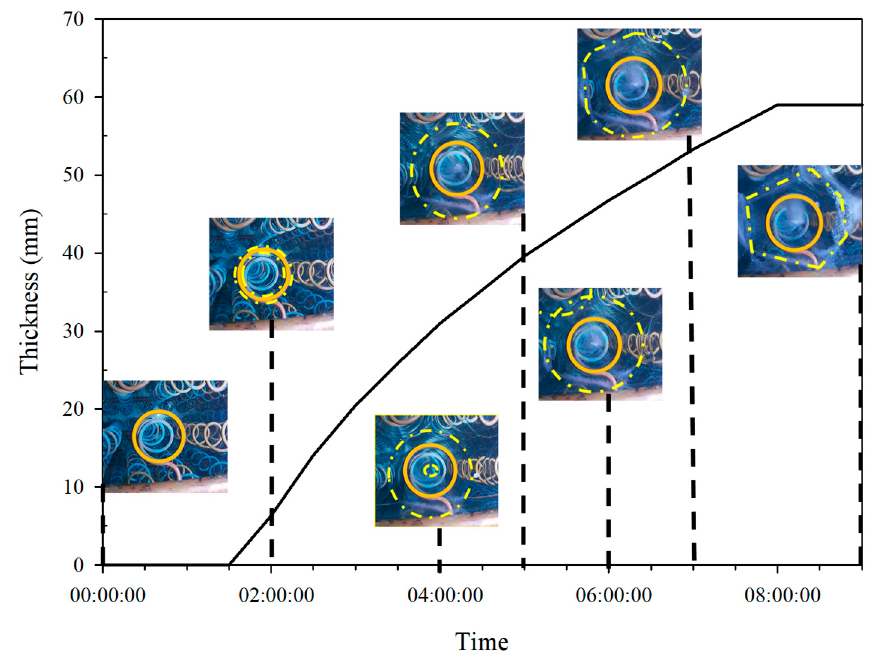
Figure 8. Time–thickness diagram of the ice.